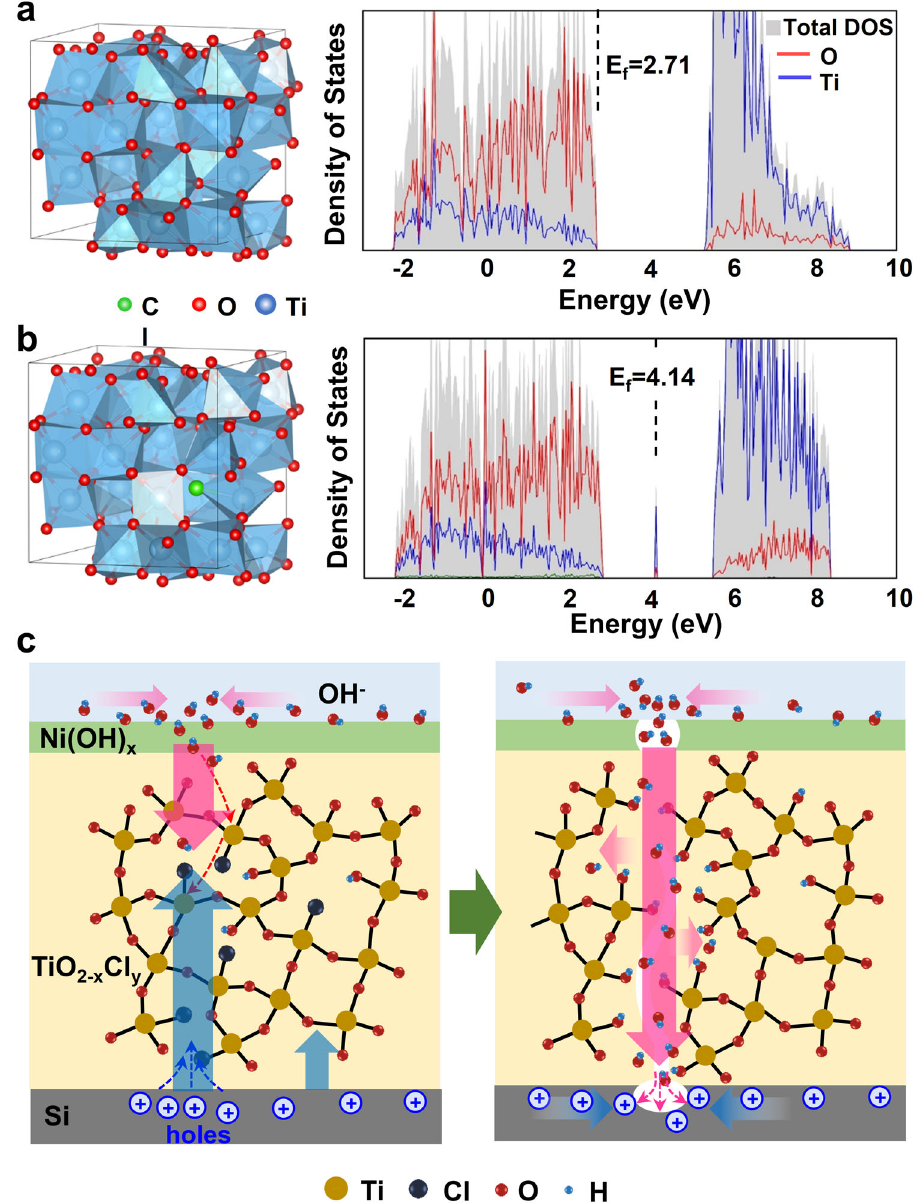
Fig. 2 | Cl-related TiO 2 failure mechanism. a , b Density of states of the melt- quenched amorphous TiO 2 and TiO 1.965 Cl 0.035 models calculated by DFT. The left insets are the polyhedral visualization of the structure of amorphous TiO 2 and